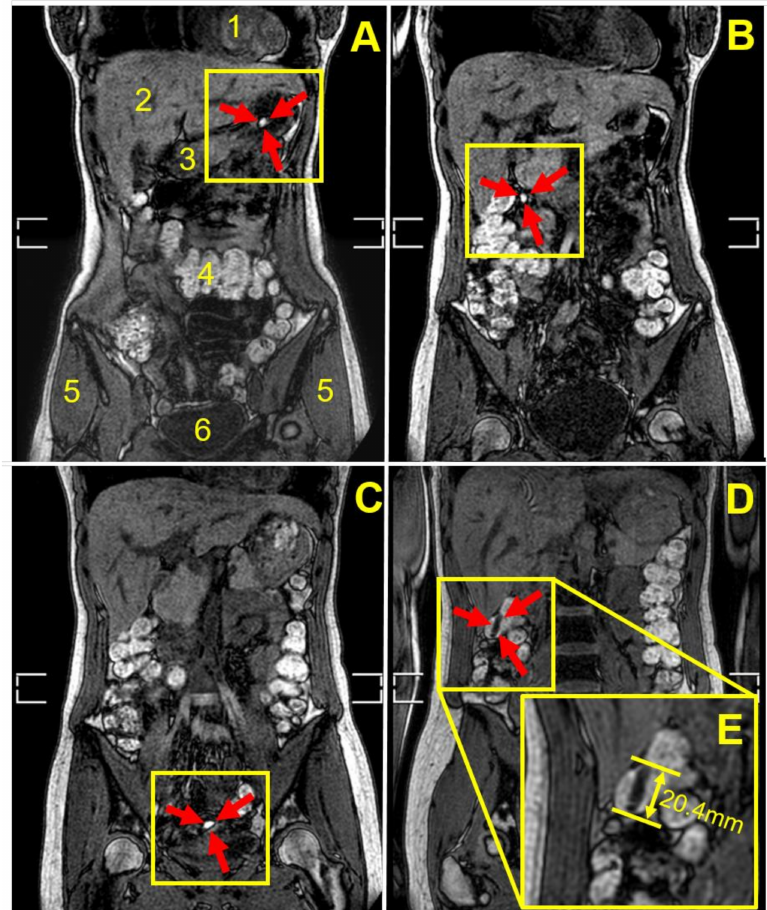
Figure 2. Coronal, fat and water out of phase MRI images of the abdomen of participant number 2 after consumption of the coated capsule co-administered with 240 mL of water. Anatomical landmarks are indicated in ( A ) by numbered labels as heart ( 1 ), liver ( 2 ), stomach antrum ( 3 ), transverse colon ( 4 ), gluteus medius muscle ( 5 ) and bladder ( 6 ). The white brackets at the side of the body derive from the fusion of the two separate breath-hold image stacks acquired. The filled capsule appears bright. It was located intact and floating in the body of the stomach 45 min after consumption as shown in panel ( A ) indicated by the red arrows inside the yellow box. The capsule was detected later in the small bowel in the duodenum 90 min ( B ) and ileum ( C ) 135 min after consumption. Finally, the capsule was located in the large intestine in the ascending colon, near the hepatic flexure, 180 min after consumption ( D ). By this time the capsule appeared to be empty of oil but still with an almost complete capsule shape, visible in ( D ) as a dark spherocylindrical object that measured 20.4 mm in length (inset ( E )).